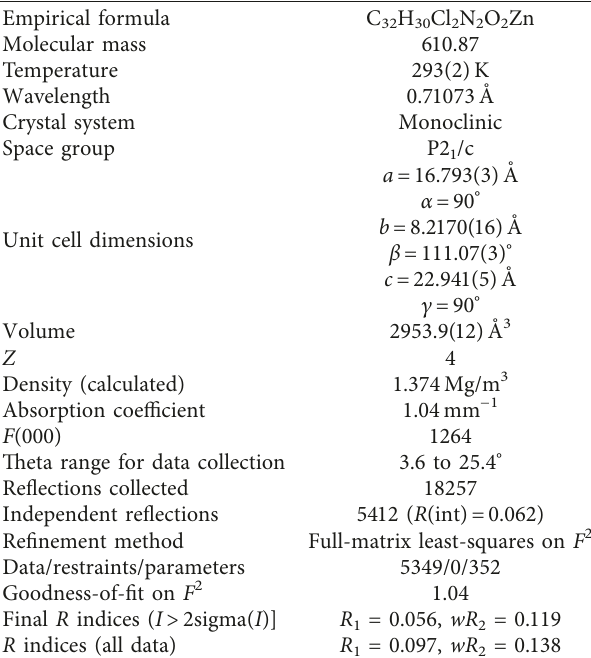
Table 1: Summary of crystal, data collection, and refinement of the [ZnCl 2 (BS-4-OCH 3 ) 2 ]